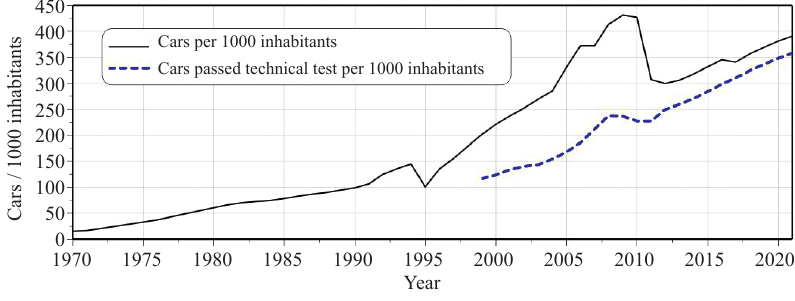
Figure 1. Car ownership growth in